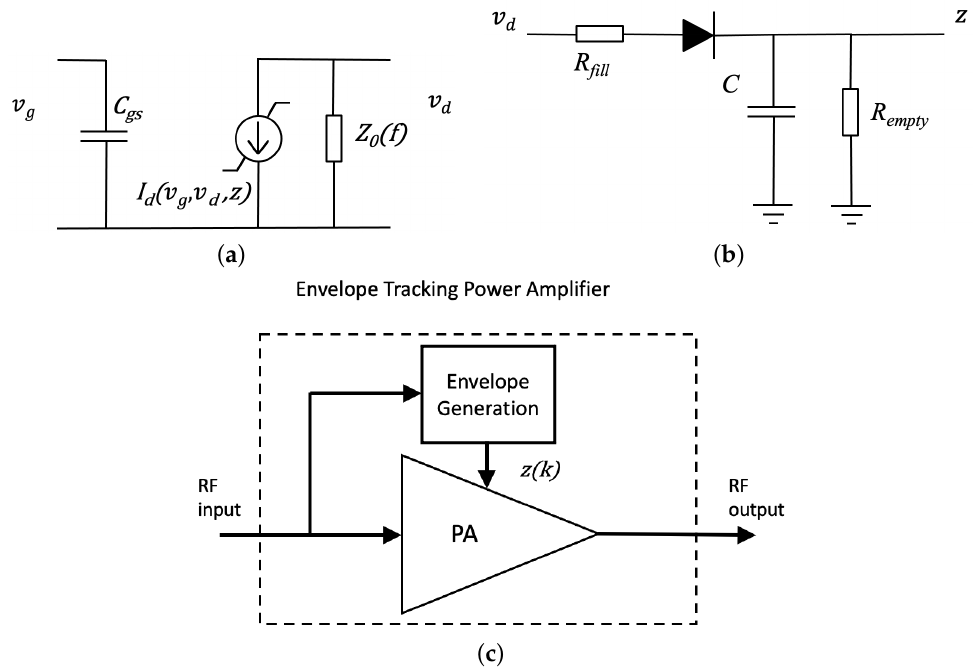
Figure 1. Simplified layouts of a single-FET amplifier ( a ), the associated charge trapping subcircuit ( b ) and the envelope tracking PA ( c ). The following elements are included: gate voltage v g , drain voltage v d , internal variable z , drain current I d , gate-to-source capacitance C gs , frequency-dependent load impedance Z 0 ( f ) , capacitance C , and resistances R fill and R empty